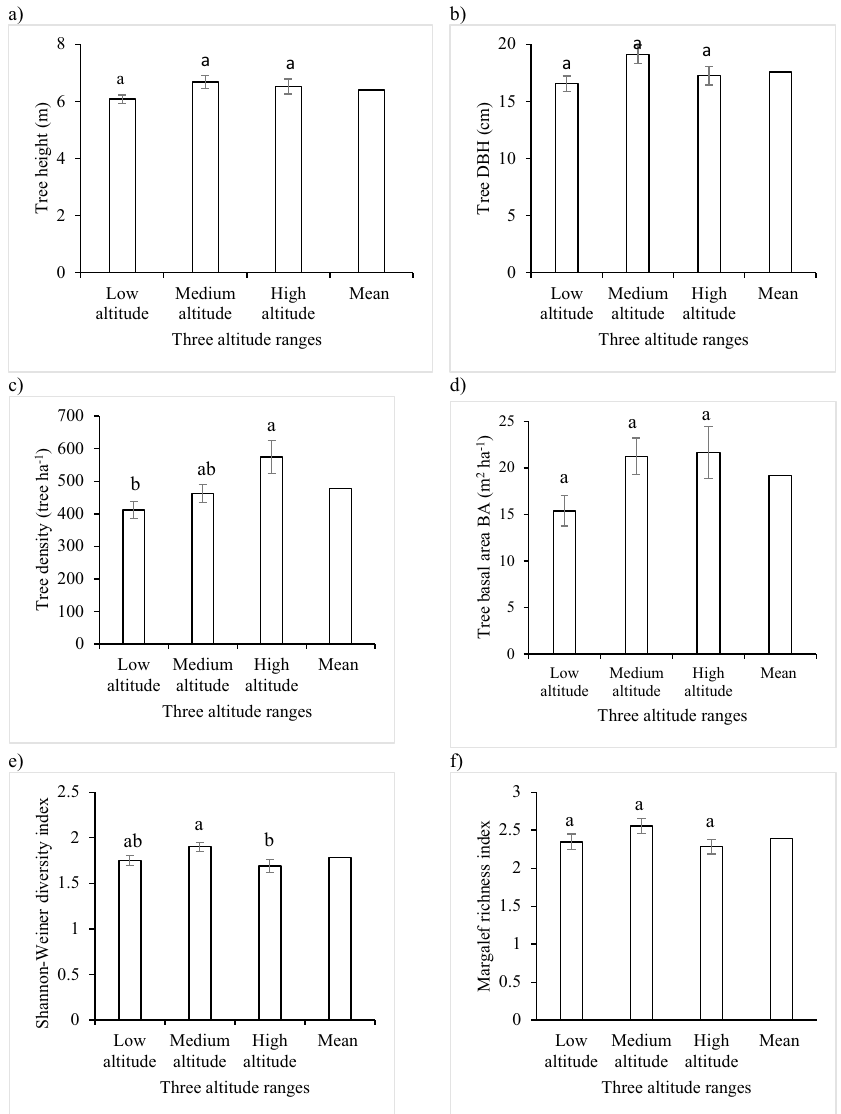
Figure 1. ( a ) Mean tree height, ( b ) DBH, ( c ) density, ( d ) BA, ( e ) species diversity, and ( f ) richness indices in the homestead forests across three altitudes. Bars represent the standard error of the mean. Different alphabets (a, b, and c) in the bars indicate the significant difference among the different altitude forests (p ≤